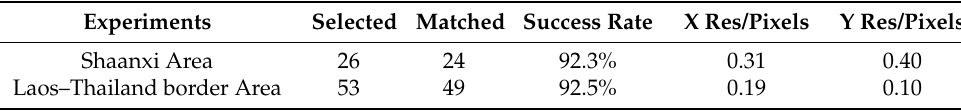
Figure 8. Registration results with considerable radiant differences. Table 1. Residuals of matched LPs in stereo images.